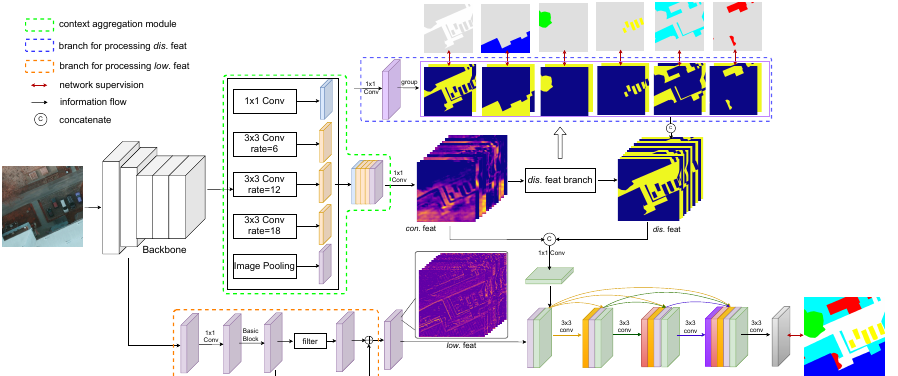
Figure 4. Detailed architecture of our proposed MFNet. It consists of a backbone network and three parts to learn three kinds of features. Finally, we apply dense connection to aggregate three features to generate prediction results. More specifically, there exists a context aggregation module (here, take ASPP [6] for example) for capturing contextual features ( con . feat), as well as two other branches for learning class-specific discriminative features ( dis . feat) and low-level features ( low .